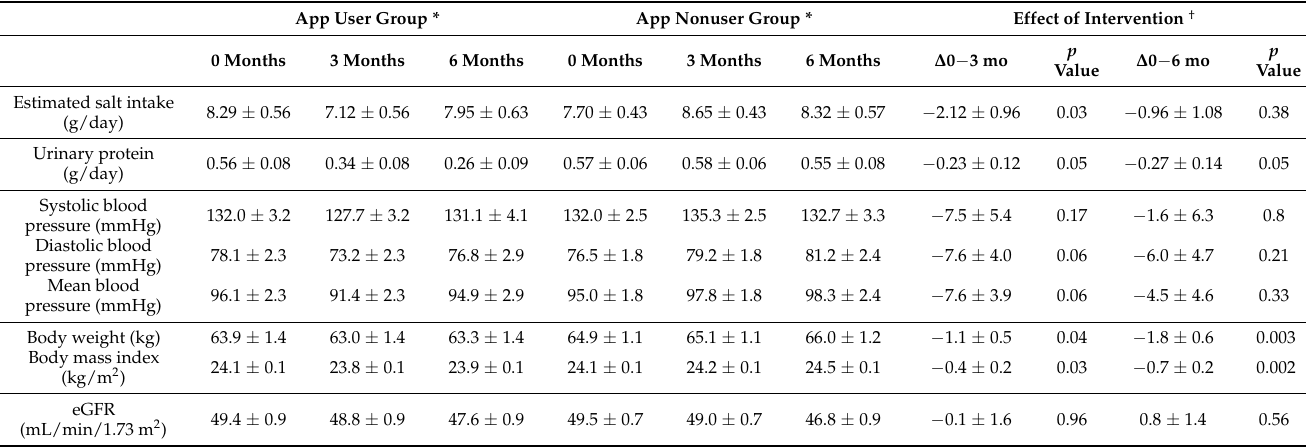
Table 3. Linear Mixed-Effects Model for the use of the Gohan Coach Smartphone Application. App User Group *